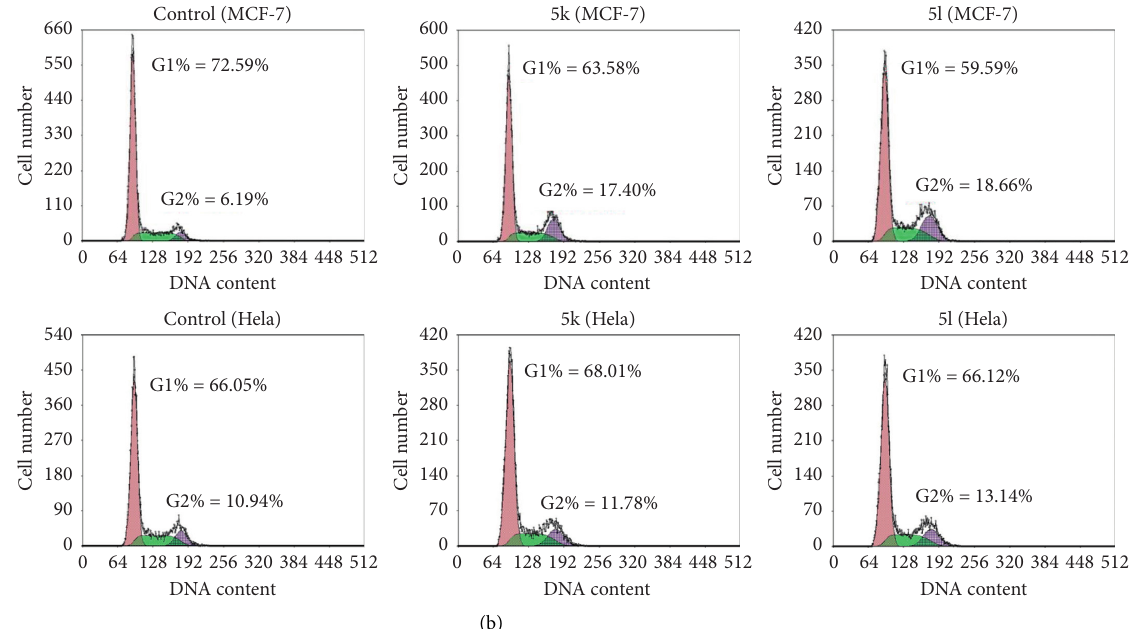
Figure 3: Effects of compounds 5k and 5l on colony formation and cell cycle disruption: (a) compounds 5k and 5l inhibited cell growth on MCF-7 cells. (b) Compounds 5k and 5l induced G2-M phase arrest.